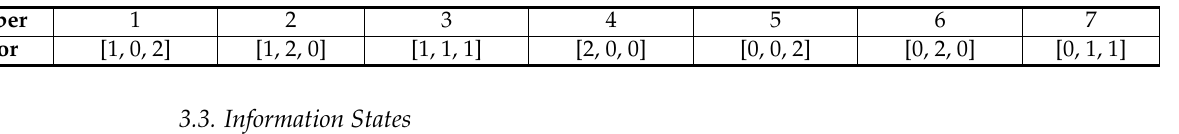
Table 2. The action set of the